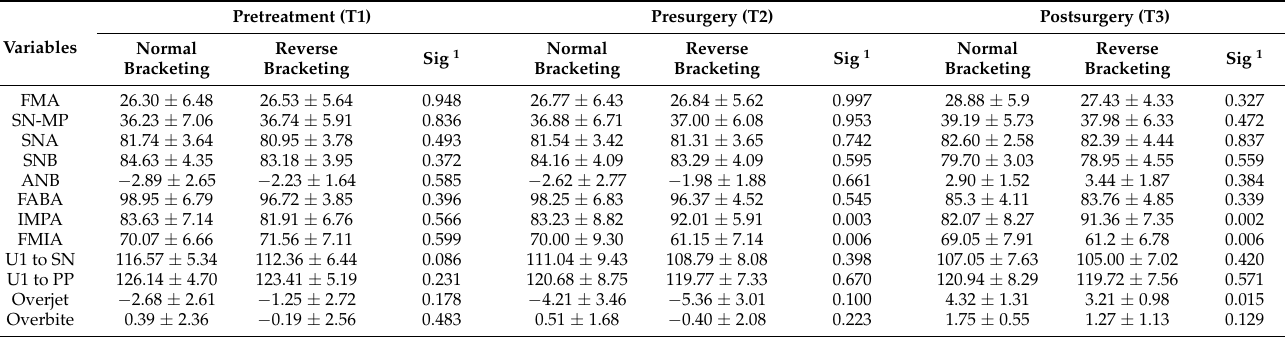
Table 2. Differences in dentoskeletal characteristics between the two groups at pretreatment, presurgery, and